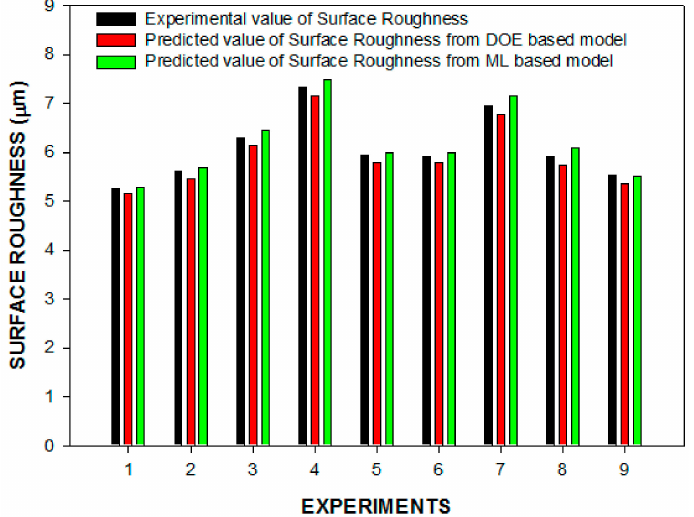
Figure 24. Comparison of DOE model and machine learning model with experimental findings for SR.